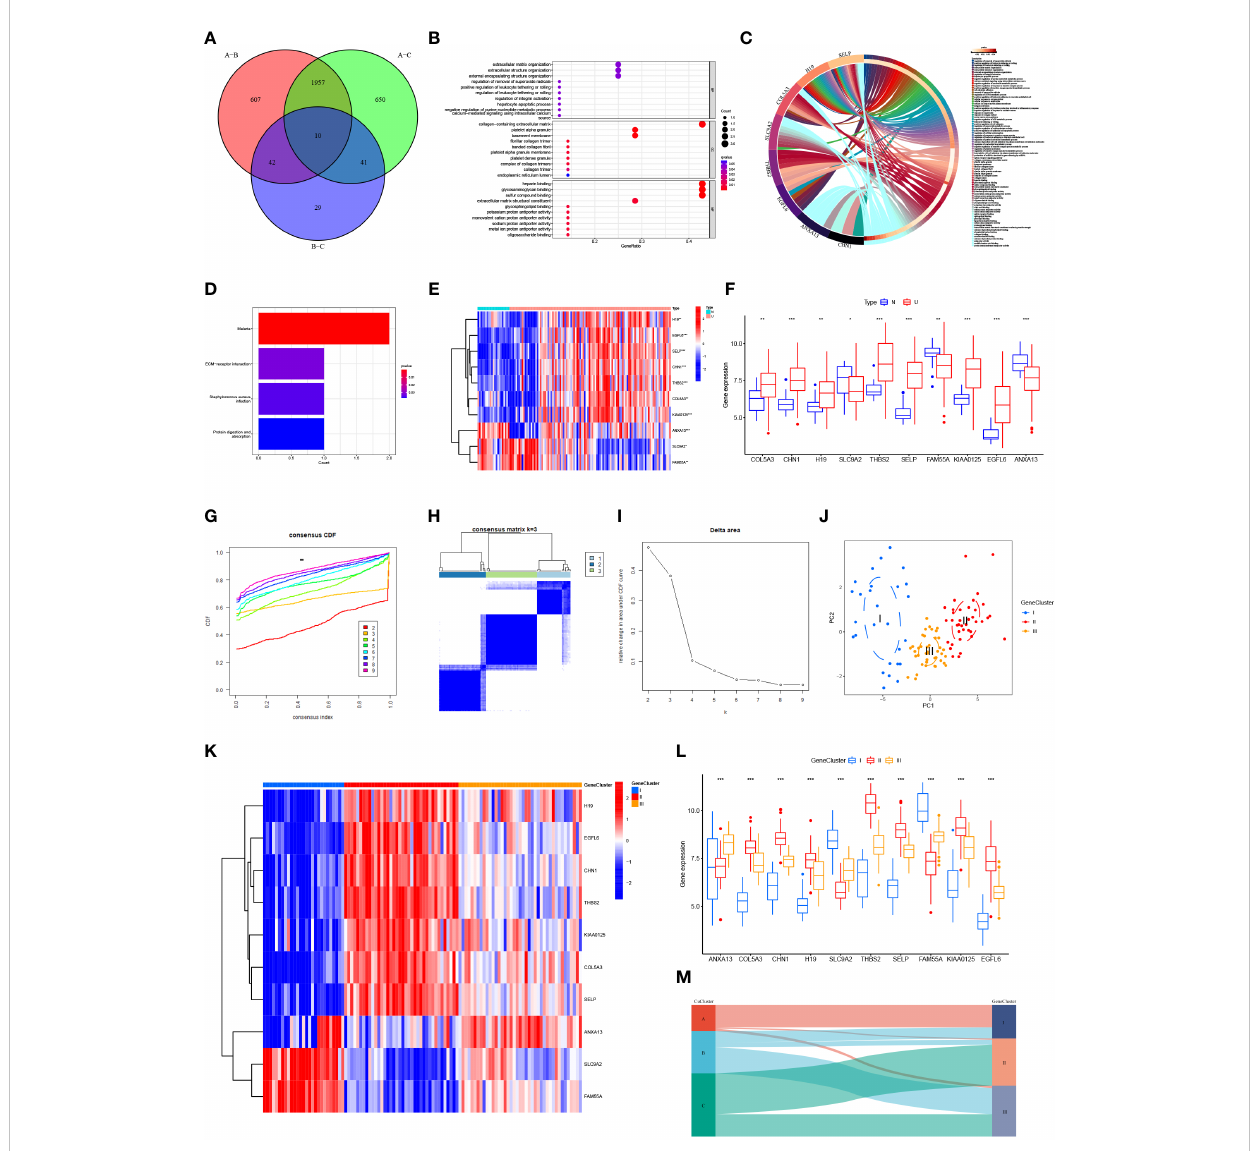
FIGURE 4 Biological characterization and consensus clustering analysis of differential genes. (A) Venn diagram of differentially expressed genes in three CuClusters. (B) Gene ontology (GO) enrichment analysis of differential genes: biological process (BP), cellular component (28), and molecular function (MF). (C) Visualization of differential gene enrichment using the Sangerbox website. (D) Kyoto Gene and Genome Encyclopedia (KEGG) pathway enrichment analysis of differential genes. (E, F) Expression of differentially expressed genes in normal tissues and in UC patients. ( G – I ) Clustering of samples based on differential gene expression using unsupervised consistent clustering to identify three subgroups. (J) Visualization of clustering results using the PCA method. (K, L) Expression of differential genes in different GeneClusters. (M) Alluvial diagram depicting the changes of CuClusters and GeneClusters. N, normal, normal tissues; U, UC, UC patients; CuClusterA, cuproptosis-ClusterA; CuClusterB, cuproptosis- ClusterB; CuClusterC, cuproptosis-ClusterC. The asterisk represents the statistical p -value (* p < 0.05; ** p < 0.01; *** p <